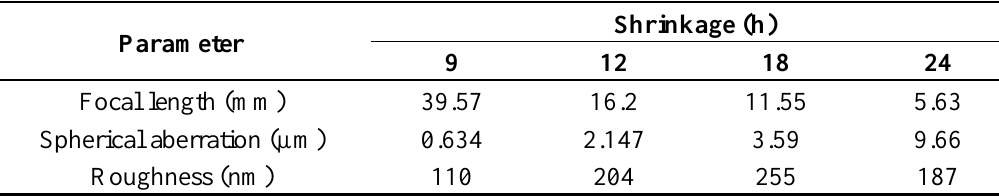
Table 2. Optical properties of PDMS microlenses with different shrinkage